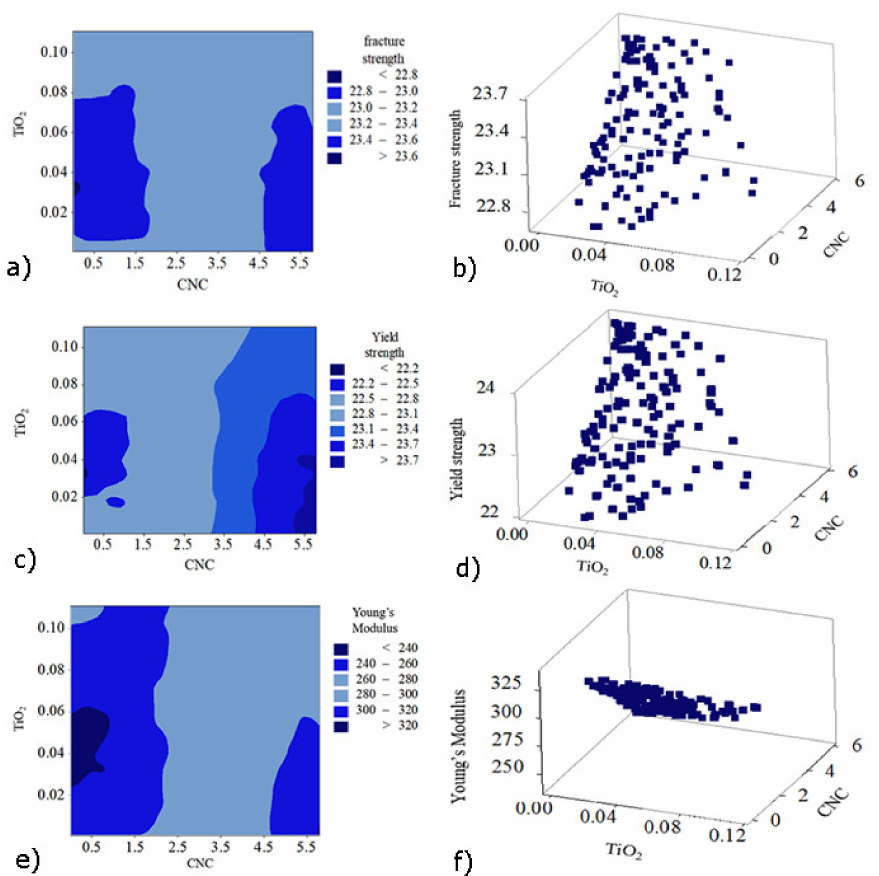
Figure 11. Scatter and Contour plots for simultaneously optimized multi-responses [fracture strength ( a , b ), yield strength ( c , d ), and Young’s modulus ( e , f )] of the developed HDPE nanobiocomposites modeled by